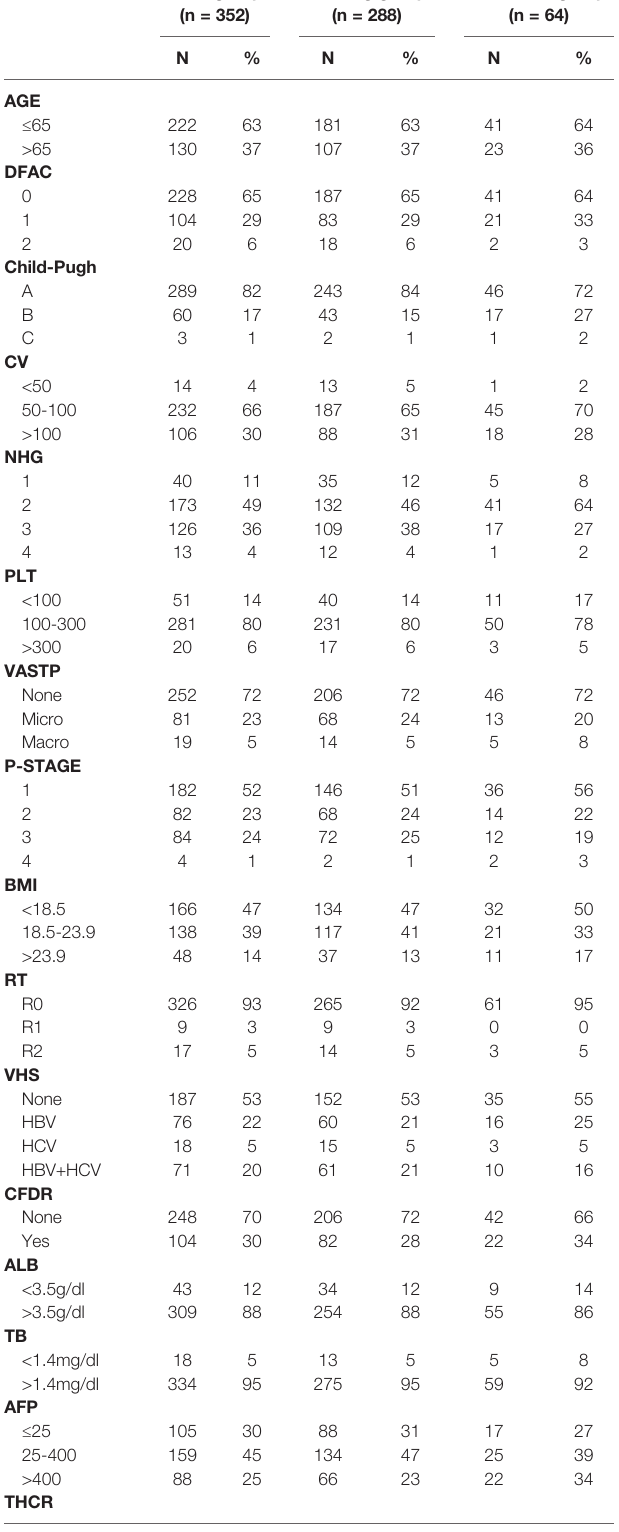
TABLE 1 | Characteristics of patients with HCC in the training and validation group.